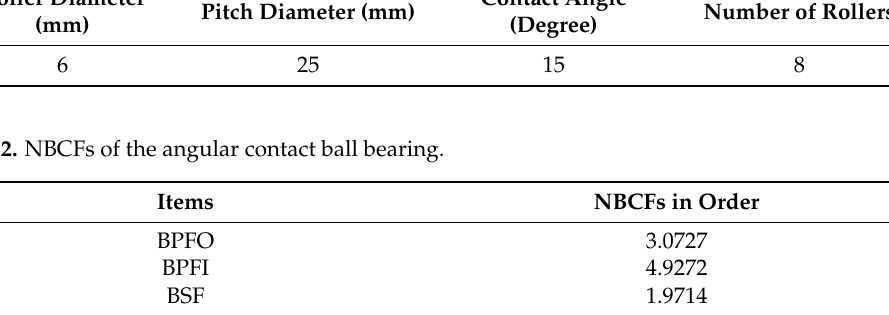
Table 2. NBCFs of the angular contact ball bearing.